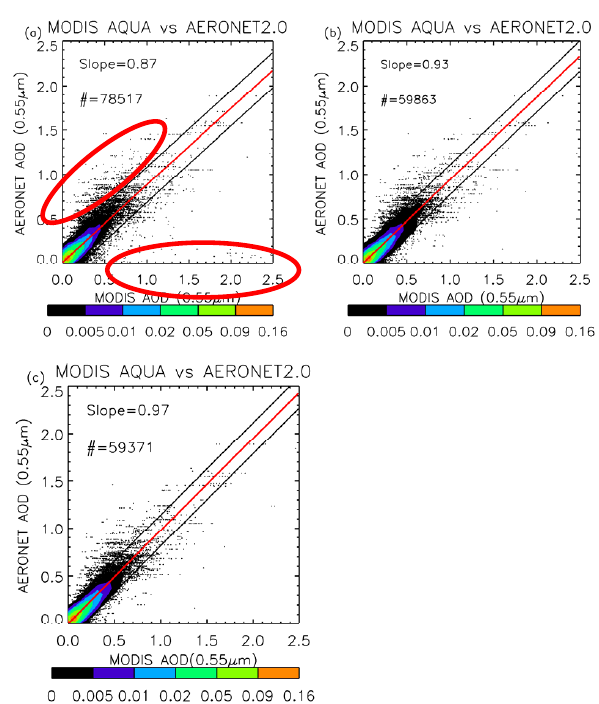
Figure 4. Fig. 4. Density plots of Aqua MODIS versus AERONET level 2.0 AOD at 0.55µm for 2002–2008. Color contour shows the number density of data per unit plotting area. Black indicates areas with low data density while orange indicates high data density regions. The red line is the linear regression line for all data and the black lines are the 1.0 standard deviation line of the red line. The red circles highlight the outliers were removed after the QA procedures. (a) for the MODIS C5 aerosol products. (b) for the aerosol data that passed the quality assurance filters. (c) for the newly generated level 3 MODIS